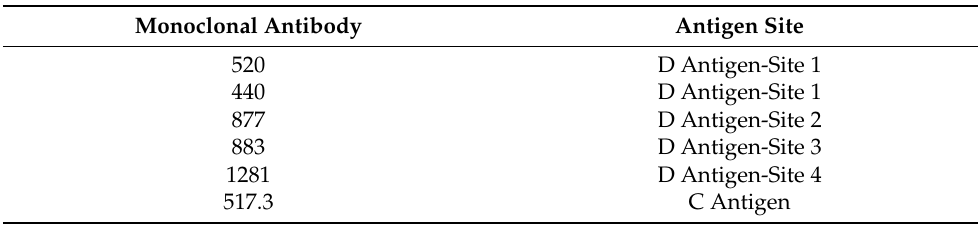
Table 1. List of monoclonal antibodies and corresponding site recognition information